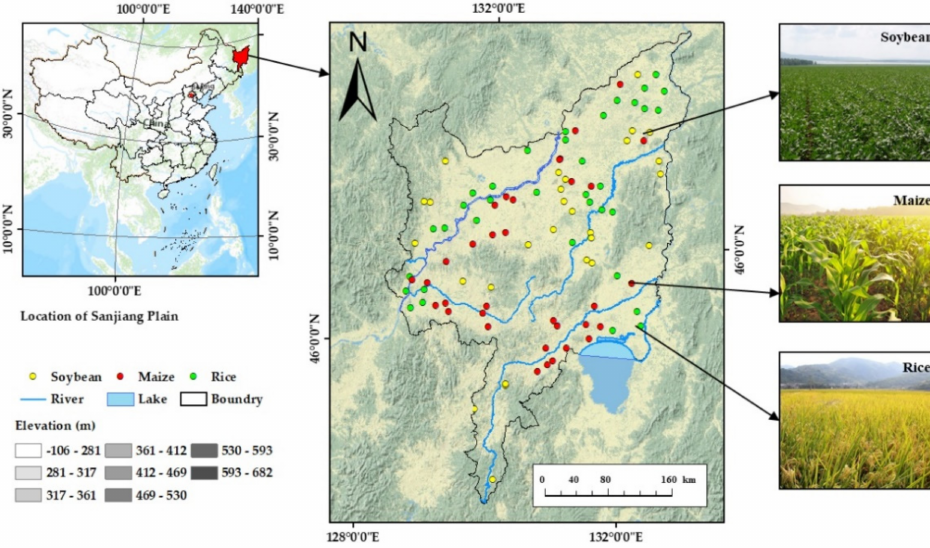
Figure 1. Overview of the study area: Sanjiang Plain, located in northeast Heilongjiang